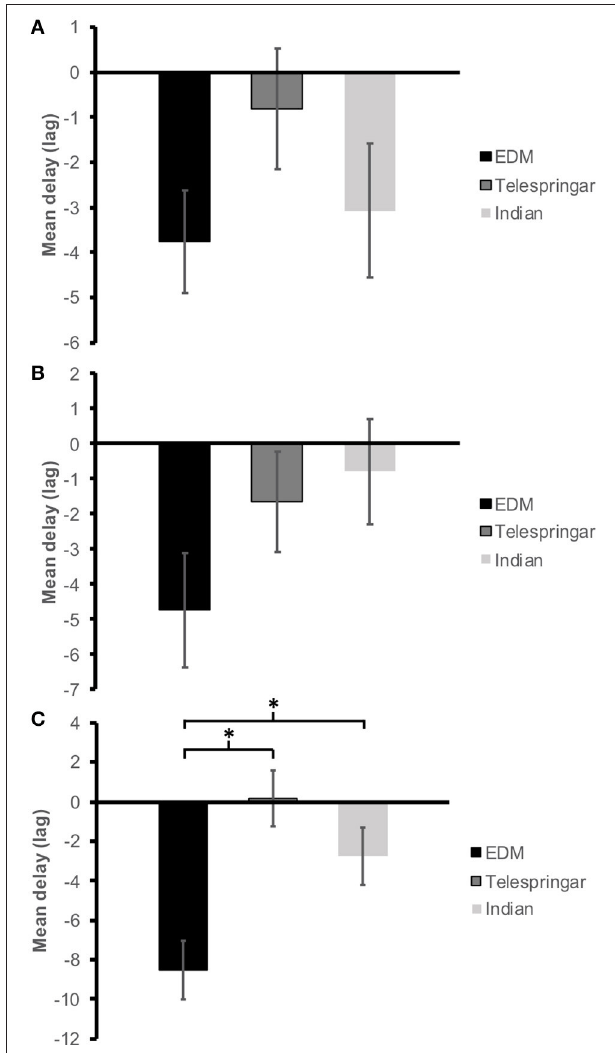
FIGURE 5 | Average lag of maximum cross-correlation (delay) between vertical QoM and extracted sound features across participants for each music stimuli. (A) Loudness (RMS), (B) Spectral centroid, (C) Pulse Clarity. Asterisk indicates significant difference at p < 0.05.